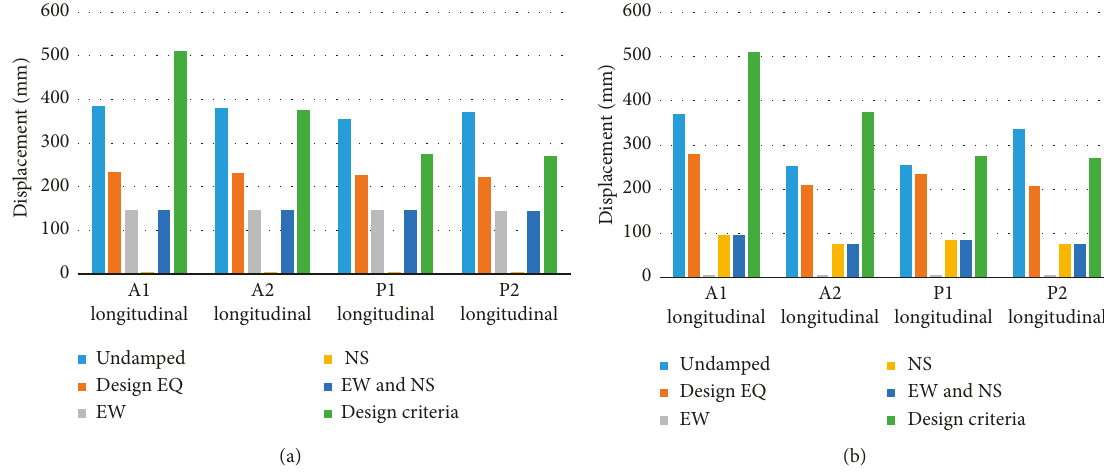
Figure 32: Spring displacement of the spring in each abutment and pier for all cases: (a) longitudinal direction and (b) transverse